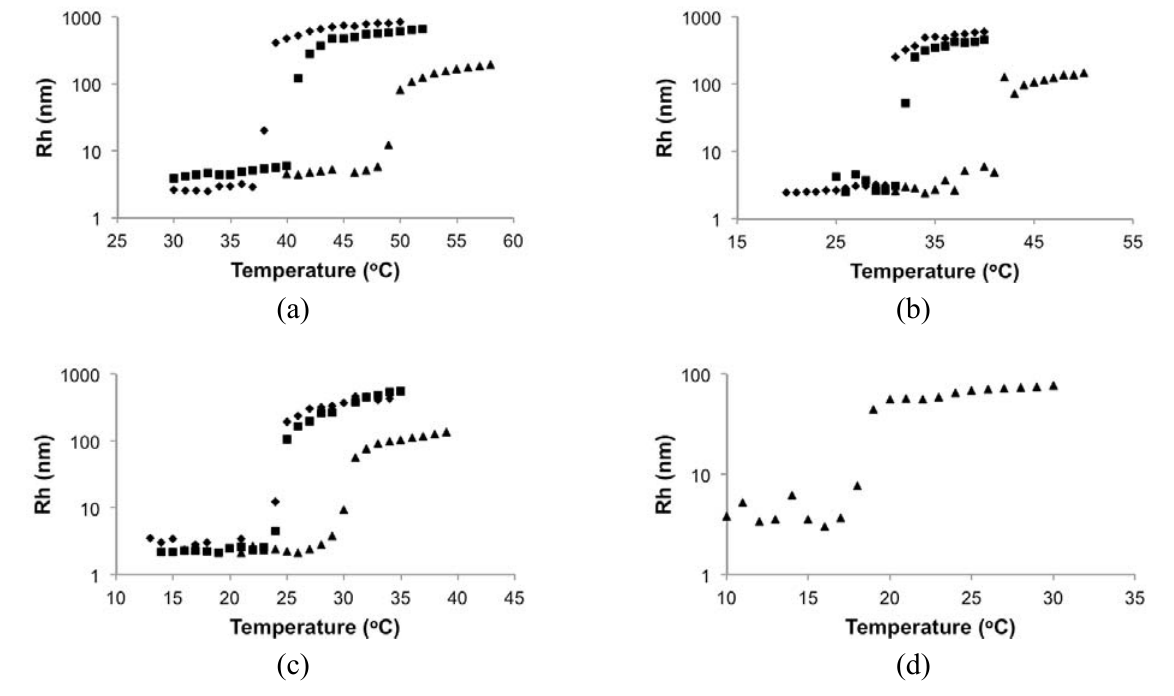
Figure 5. Hydrodynamic radii of copolymers (R poly(DMAEMA- stat -styrene) copolymers with (a) F (b) F = 89 mol% (DMAEMA/S-90/10) (c) F DMAEMA (d) F = 81 mol% (DMAEMA/S-80/20) at 0.1 wt% ( ▲ ), 0.3 wt% ( (cid:132) ) and 0.5 wt% DMAEMA ( (cid:139) ) in de-ionized water measured by dynamic light